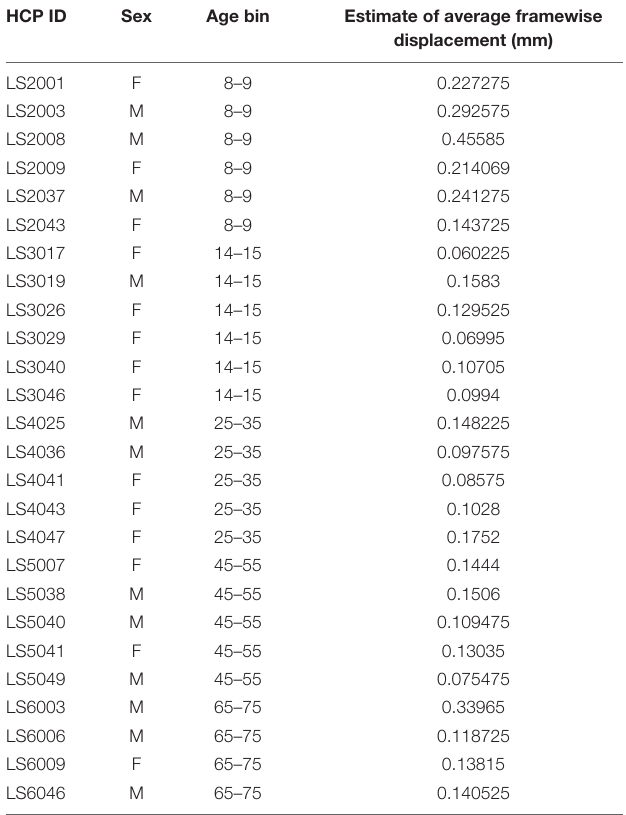
TABLE 1 | Sex, age, and average framewise displacement values for each subject in the HCP Lifespan